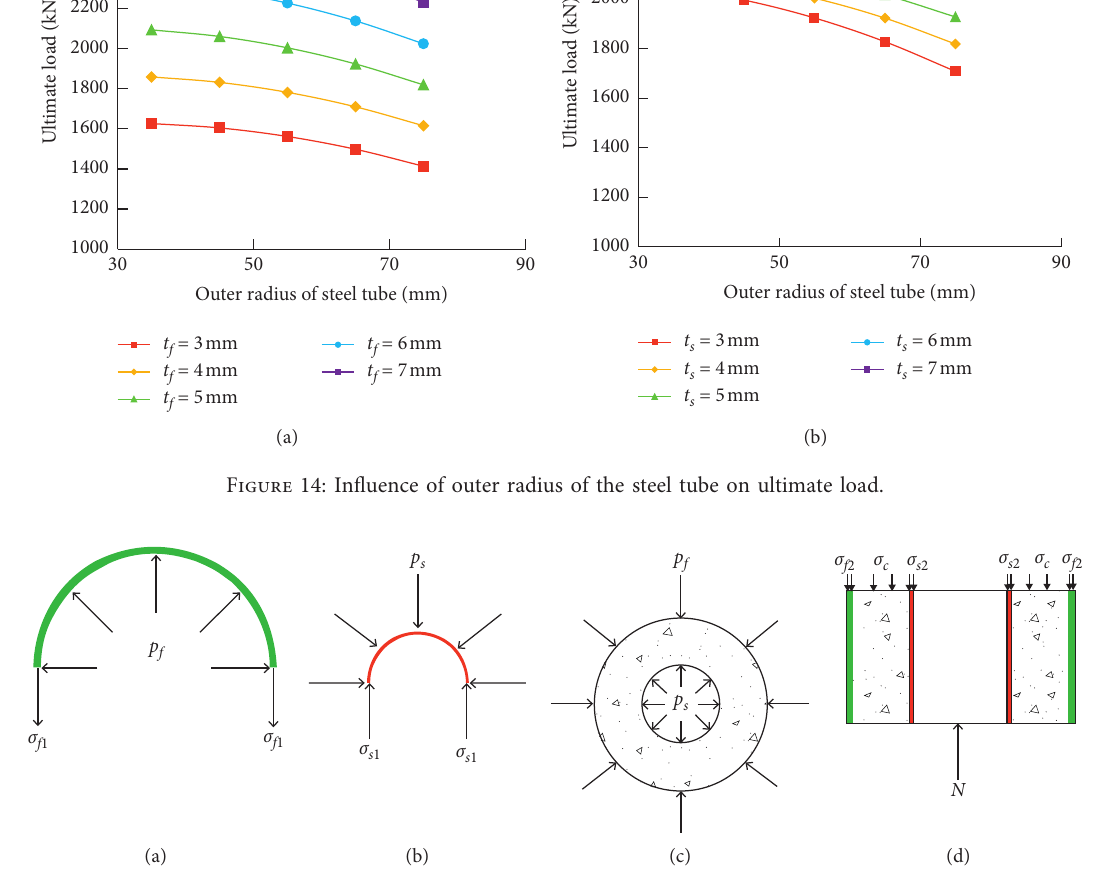
Figure 15: Force diagram of GGCS hollow column. (a) Glass fiber tube. (b) Steel tube. (c) Gangue concrete. (d) GGCS hollow column.